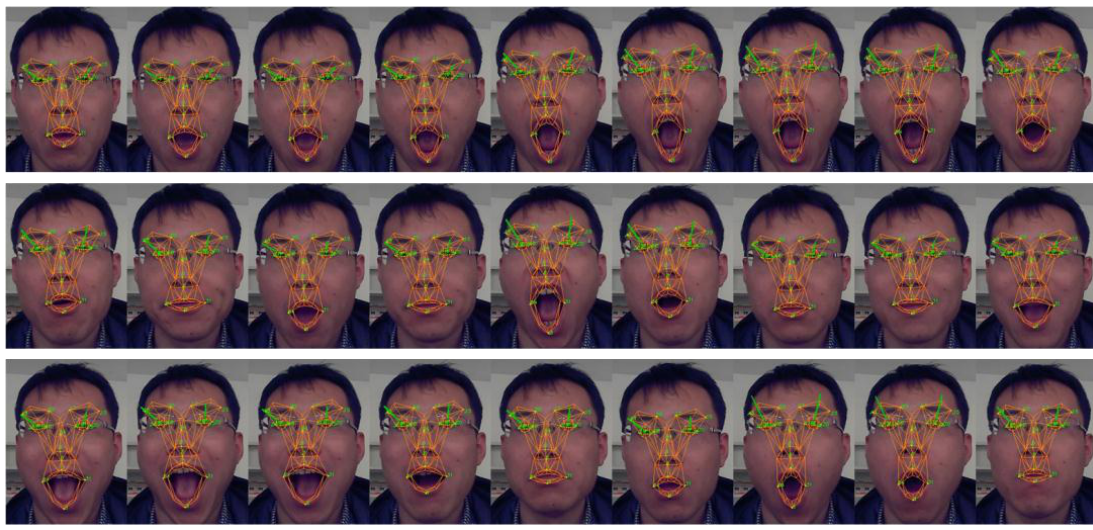
Figure 10. Sample images of mouth movement tracking. Their corresponding mouth metrics are the dot points on the curves in Figure 9.